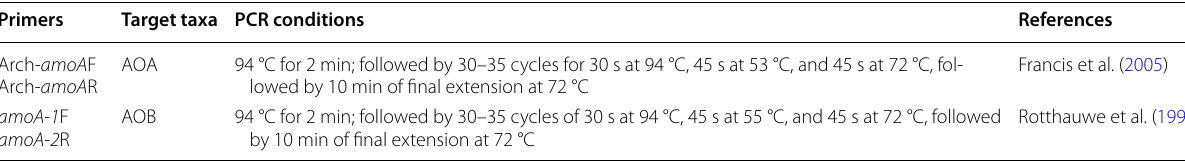
AOA ammonia-oxidizing archaea, AOB ammonia-oxidizing bacteria